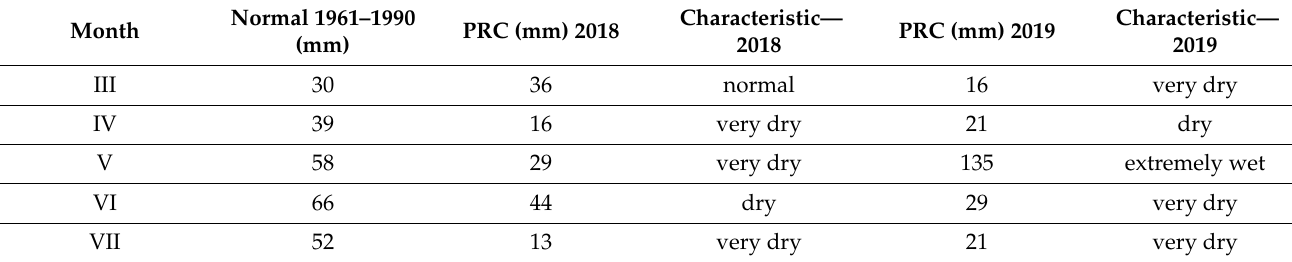
Table 4. Evaluation of months according to annual precipitation climate normals